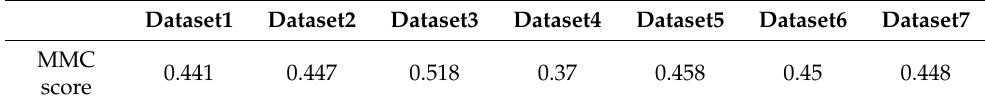
Table 5. MMC score between SentiStrength-SE and